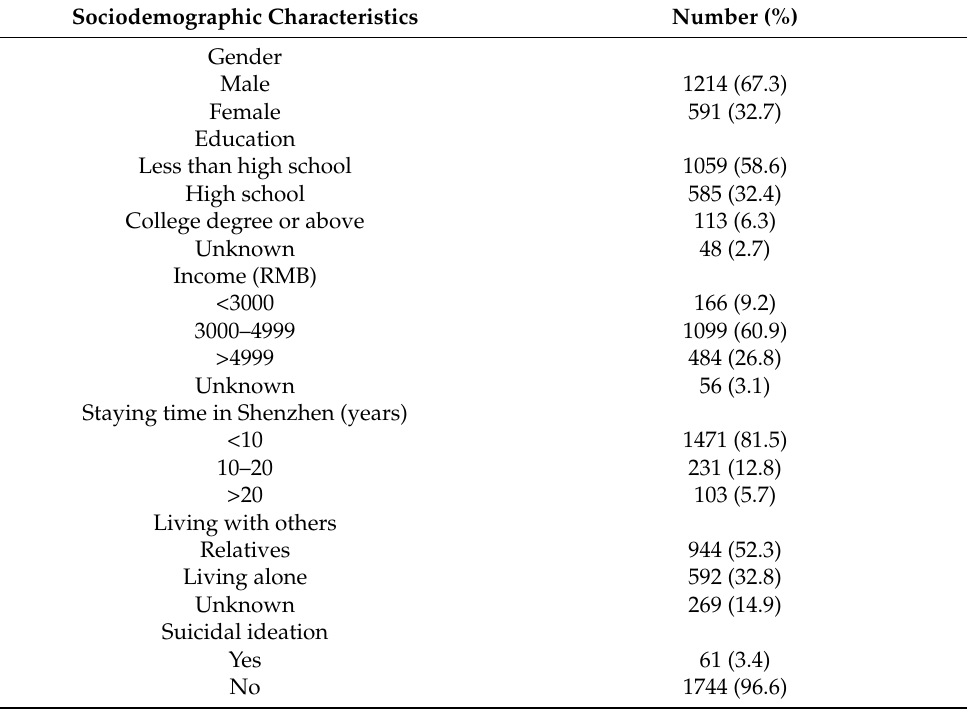
Table 1. Sociodemographic characteristics of industrial workers. ( n = 1805).